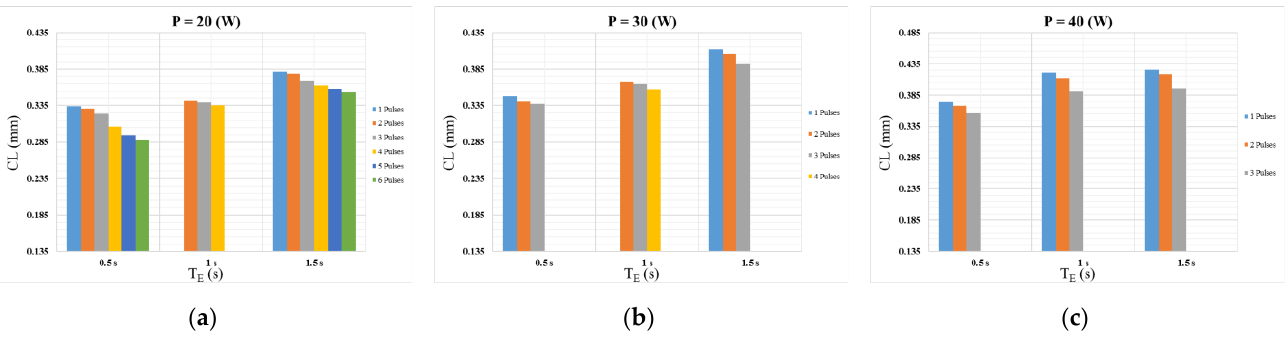
Figure 4. Influence of T E and N P on CL for 0.075 wt.% of CNPs and ( a ) P = 20 W, ( b ) P = 30 W and ( c ) P = 40 W.